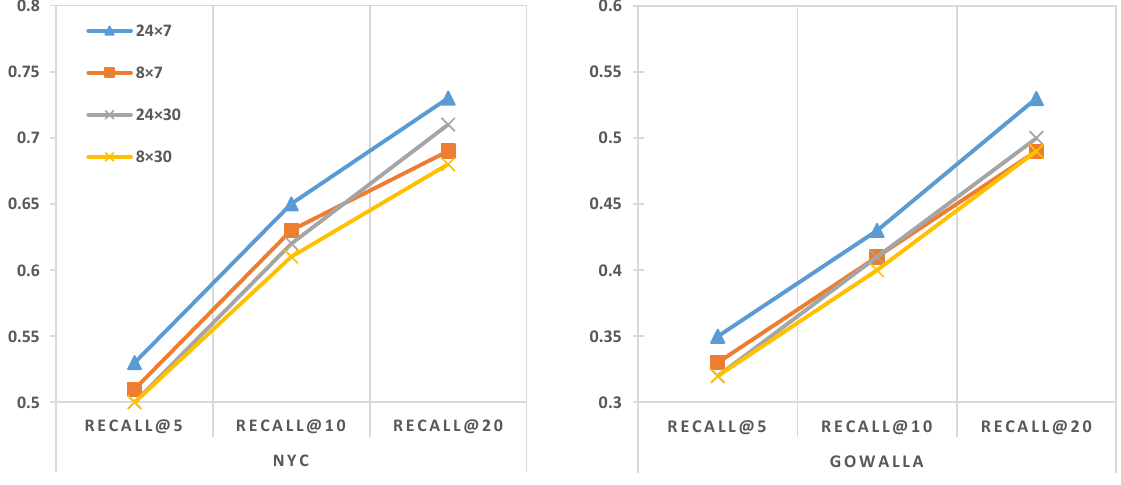
Figure 5. The Impact of Different Time